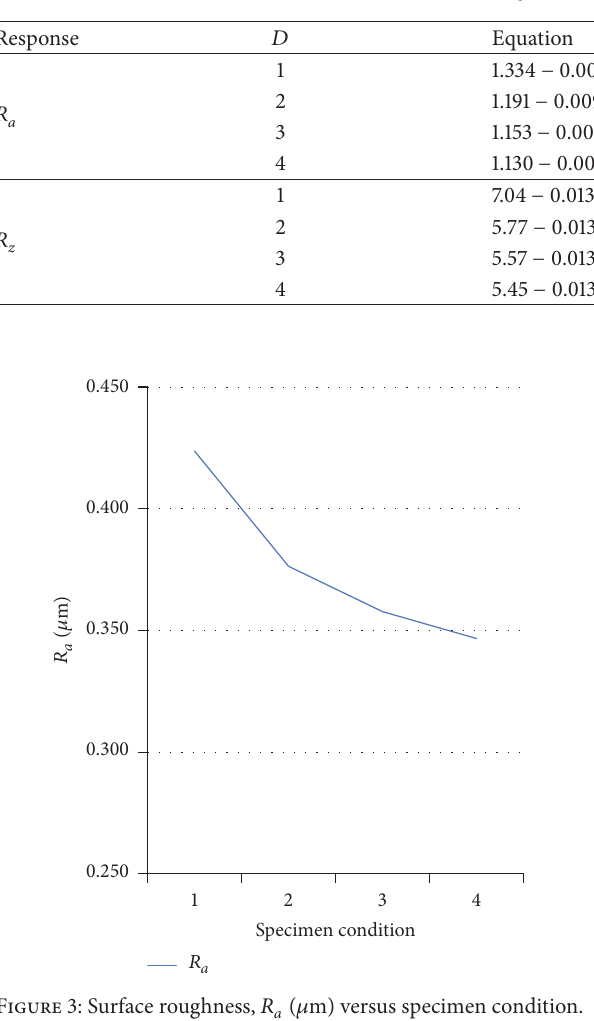
Table 4: Quadratic models for 𝑅 𝑎 , and 𝑅 𝑧 .